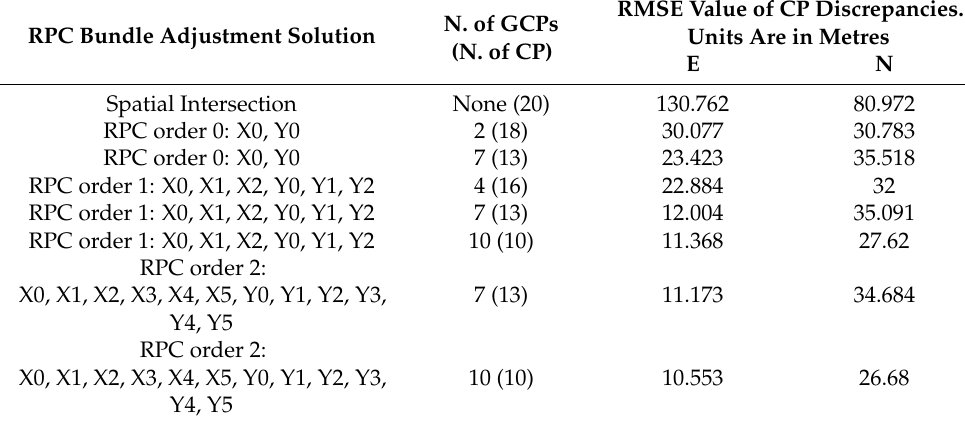
Table 6. Results of RPC bundle adjustment with bias compensation for